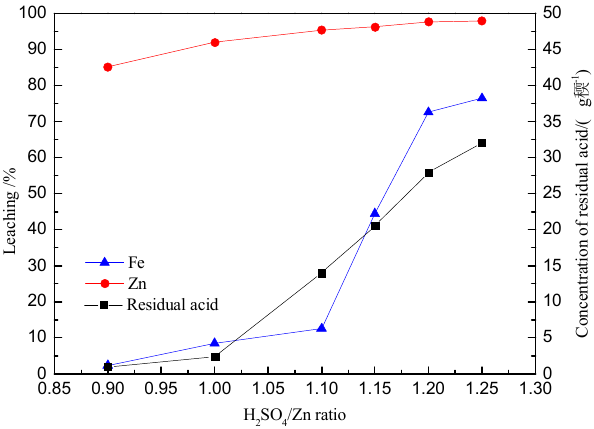
Figure 7. Effect of H 2 SO 4 /Zn on the extractions of Zn and Fe. Figure 7. E ff ect of H 2 SO 4 / Zn on the extractions of Zn and Fe.